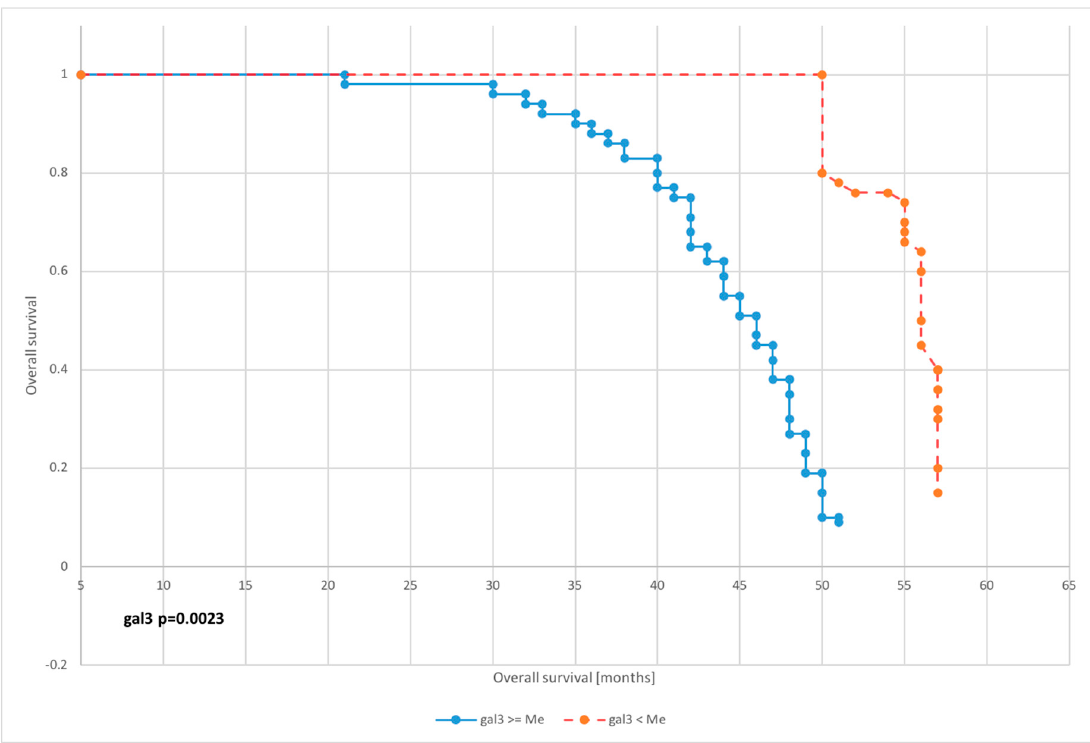
Figure 4. Kaplan–Meier recurrence-free survival curves for endometrial cancer patients based on serum galectin 3 level for median.